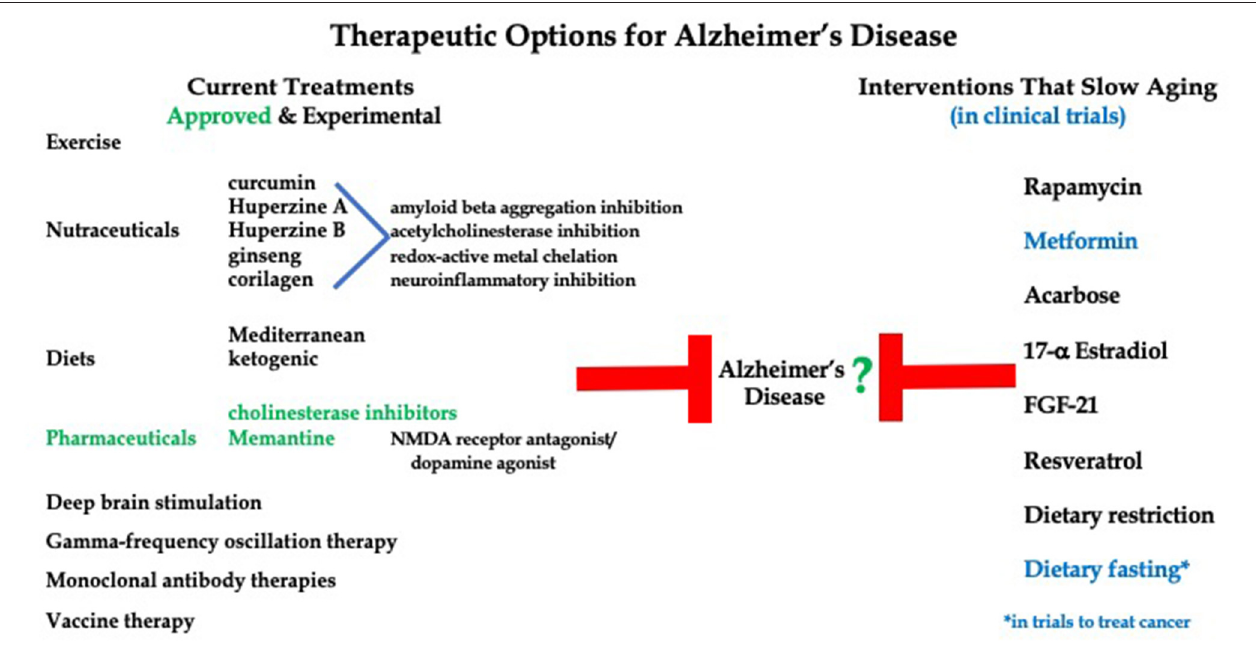
FIGURE 1 | Current therapies to treat Alzheimer’s Disease symptoms and pathologies versus potential therapies for AD that have been shown to delay